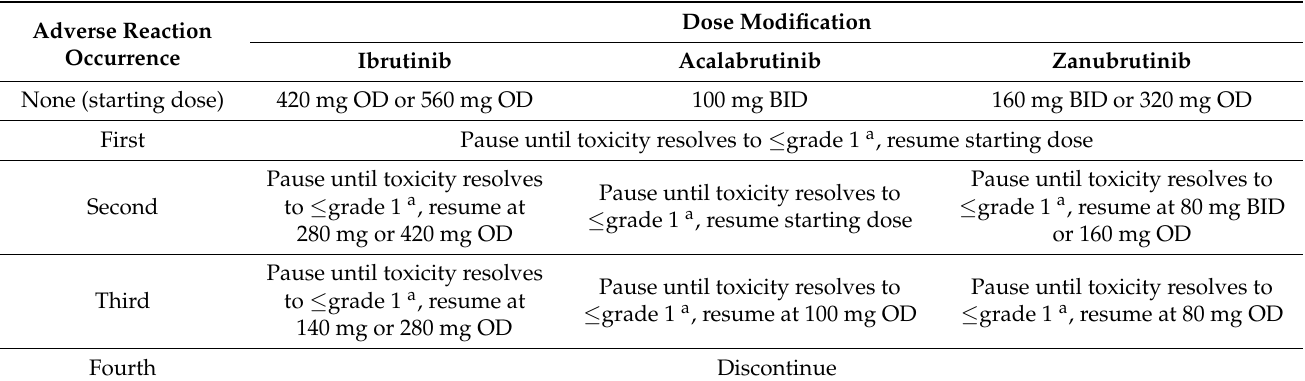
Table 5. Recommended BTK inhibitor dose modifications for grade 4 hematological toxicity, grade